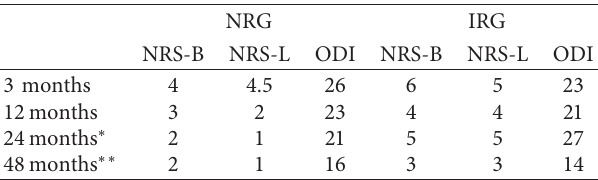
Table 4: Pain and disability